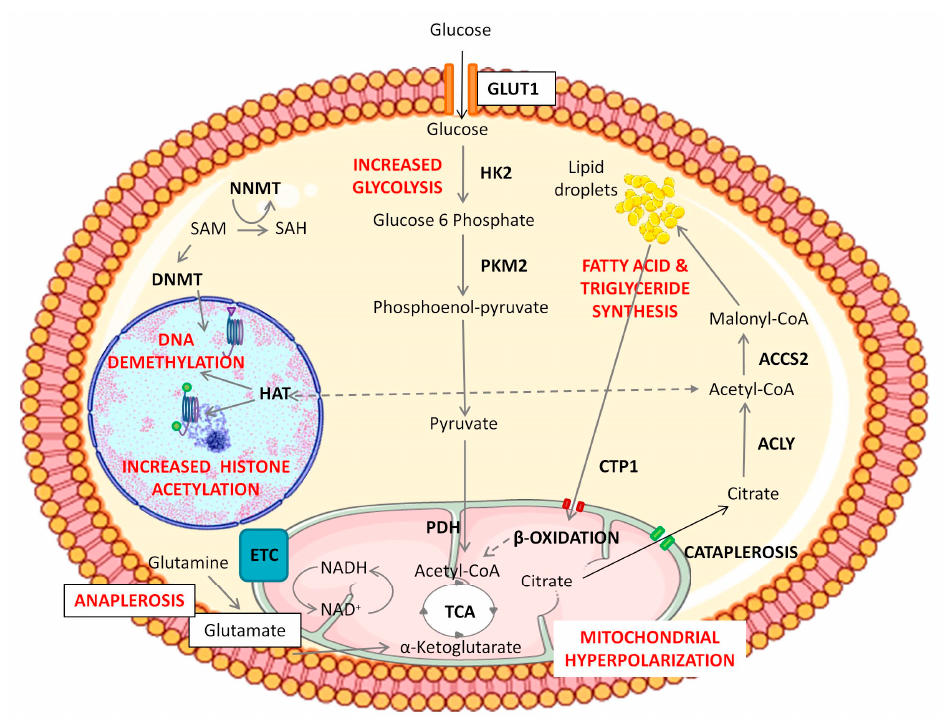
Figure 2. Representation of epigenetic and metabolic changes during Notch/Wnt activation in DPSCs. Notch/Wnt signaling activation triggers an increase in glucose consumption by overexpression of glycolytic enzymes HK2 and/or PKM2. Pyruvate dehydrogenase complex subunits are also upregulated in BIO/WNT-3A treated DPSCs and this leads to the generation of Acetyl-CoA to fuel the mitochondrial TCA cycle. These “hyper-energized” DPSCs show a net accumulation of lipids and a mitochondrial hyperpolarization, implying a higher activity of the TCA cycle. Overexpression of cytosolic ACLY and ACSS2 enzymes also suggests transport of citrate from mitochondria to the cytosol (cataplerosis) eventually leading to a cytosolic accumulation of Acetyl-CoA, which can be then used to sustain higher levels of histone acetylation, also supported by a HAT overexpression. Meanwhile, mitochondria consume amino acids such as glutamine and glutamate to replenish the exported TCA metabolites in a coordinated cycle of cataplerosis and anaplerosis. Cytosolic fatty acids also appear to participate in the maintenance of this cycle, as suggested by the overexpression of mitochondrial fatty acid transporters (CPT1) and β -oxidation enzymes under Notch/Wnt stimulation. Thus, de novo synthesized lipids could play a role as a storage reserve of Acetyl-CoA, by feeding the mitochondrial TCA cycle and inducing citrate cataplerosis. DPSCs thus show a boost in glycolysis together with stimulation of mitochondrial activity but without cytosolic lactate accumulation. The goal of that metabolic switch seems to provide for high levels of histone acetylation to maintain DPSCs in a non-differentiated state. Changes are also observed at DNA and histone methylation levels in Notch/Wnt stimulated DPSCs. The Figure was partly generated using Servier Medical